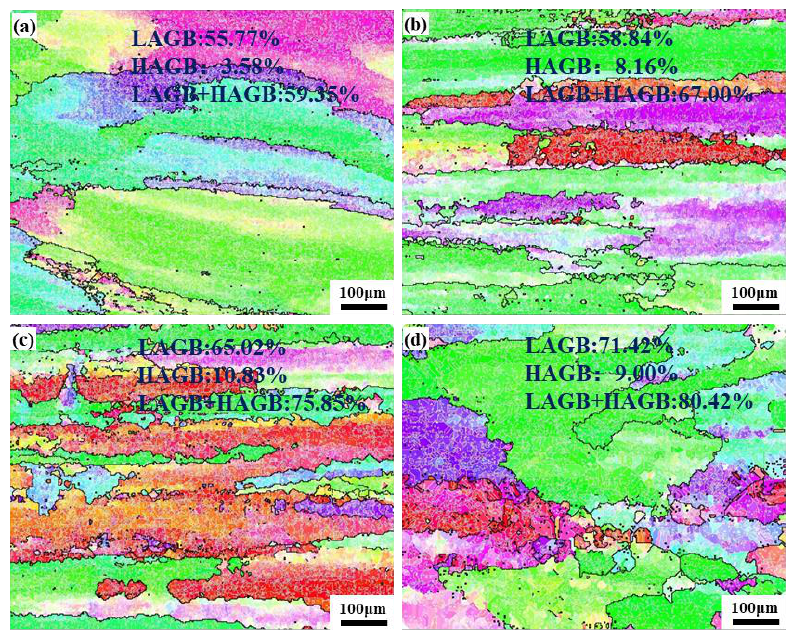
Figure 10. EBSD maps of the O-state alloy after a tensile strain of 0.12 at ( a ) 298 K, ( b ) 218 K, ( c ) 138 K, and ( d ) 77 K.